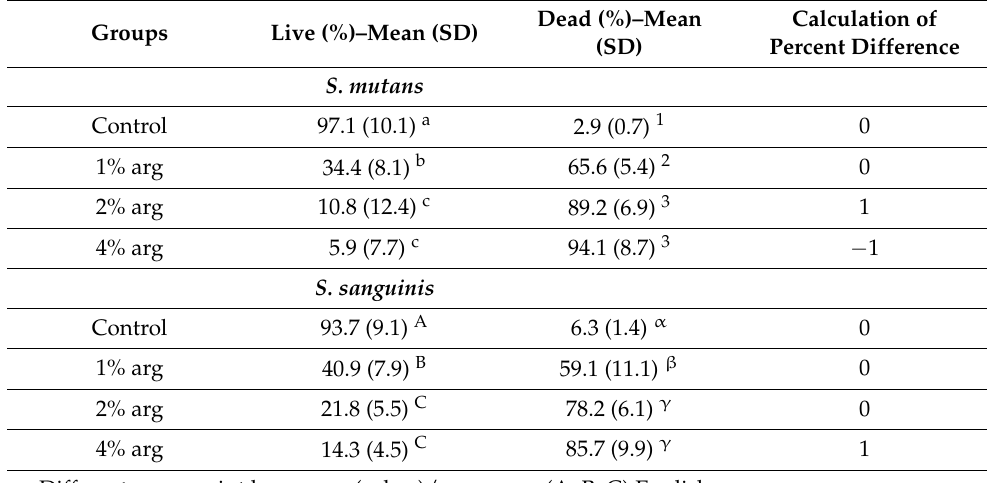
Table 1. Bacterial live/dead proportions in mono-species biofilms treated for 7-days. Groups